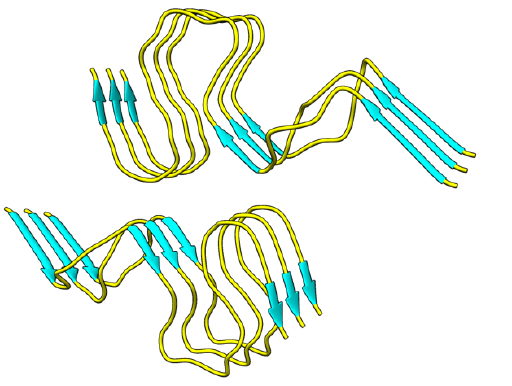
Figure 1. Disease-relevant polymorph of A β 42 fibril (PDB: 2NAO) used for molecular docking and molecular dynamic (MD) simulations. β -structured regions are shown in cyan and non- β -structured regions are shown in yellow.